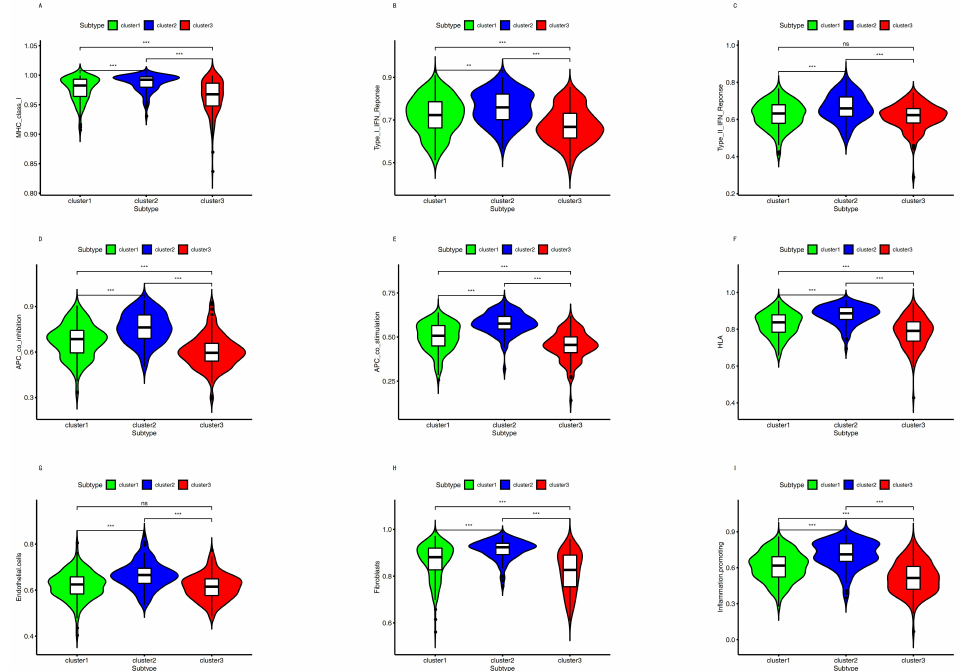
Figure 5. Immune-related molecular biomarkers among the three clusters. ( A ) MHC_class_I. ( B ) Type_I_IFN_Response.( C )Type_II_IFN_Response. ( D )APC_co_inhibition. ( E )APC_costimulation. ( F ) HLA. ( G ) Endothelial cells. ( H ) Fibroblasts. ( I ) Inflammation-promoting. Three asterisks indicate a p -value less than 0.001. Two asterisks indicate a p -value less than 0.01. Ns indicates no significance.